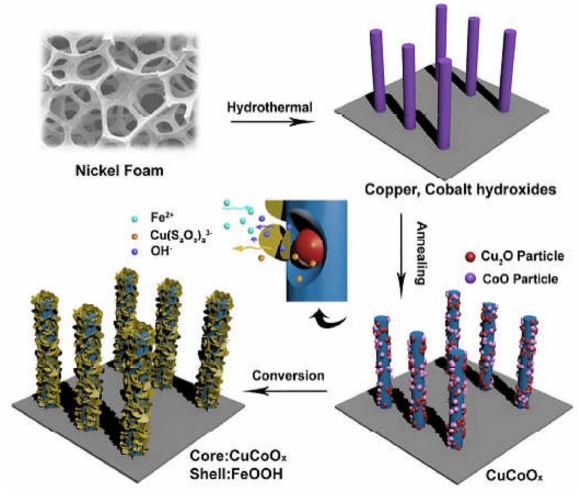
Figure 13. Schematic illustration showing the fabrication of the CuCoO x /FeOOH hybrid nanowire electrocatalysts, including the growth, annealing and conversion synthesis process. Copyright 2017 by American Chemical Society